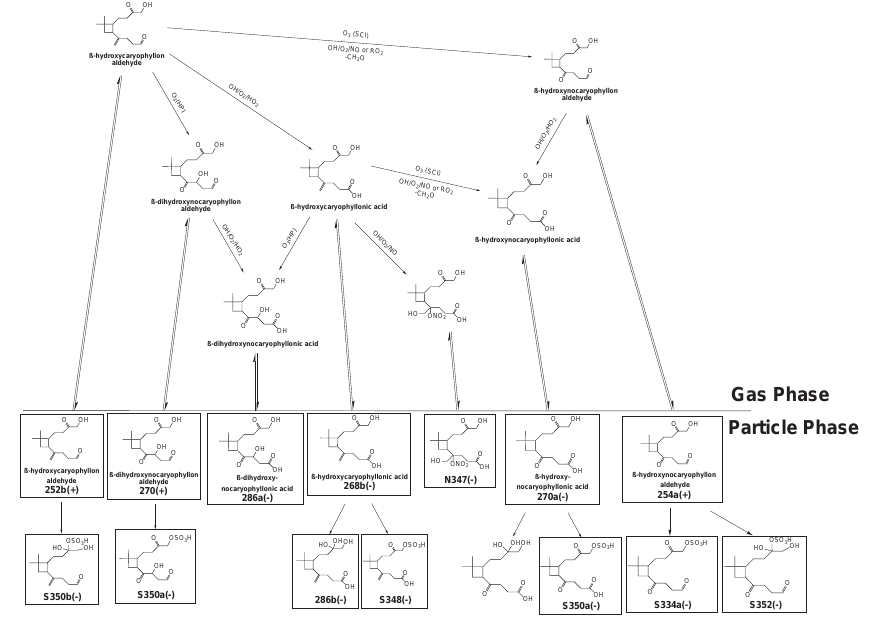
Scheme 3. Proposed reaction pathways of β -hydroxycaryophyllon aldehyde, leading to compounds detected by ESI in the particle phase. Formation mechanism of β -hydroxycaryophyllon aldehyde from the ozonolysis of β -caryophyllene (Winterhalter et al., 2009). β -14- hydroxycaryophyllon aldehyde is chosen as illustration. Boxes indicate compounds detected by ESI in the particle phase. One possible structural isomer is shown. SCI is the stabilized Criegee intermediates channel. HP is the hydroperoxide channel.